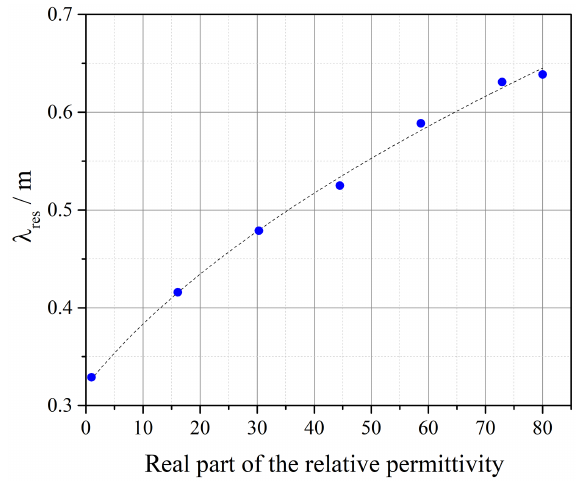
Figure 9. Dependency between the resonance wavelength and the real part of the relative permittivity.